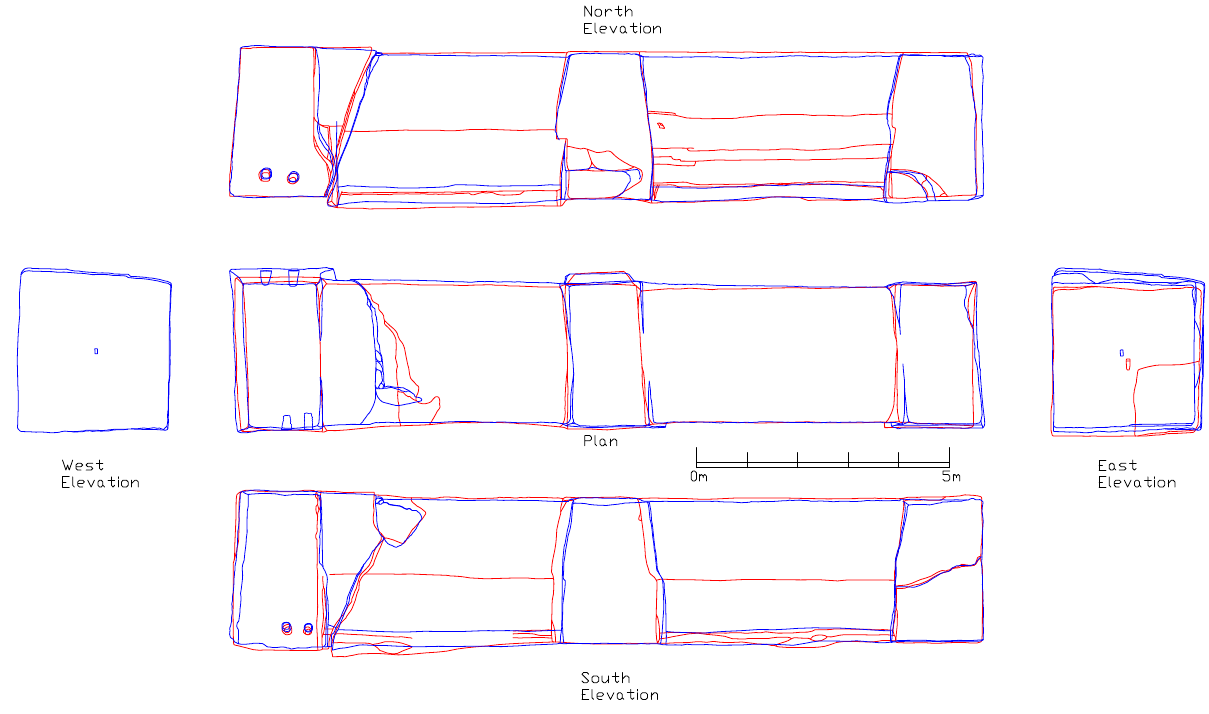
Figure 5. Comparison with the results coming from two methods (Blue lines are the result of laser scanner. Red lines are the result of the